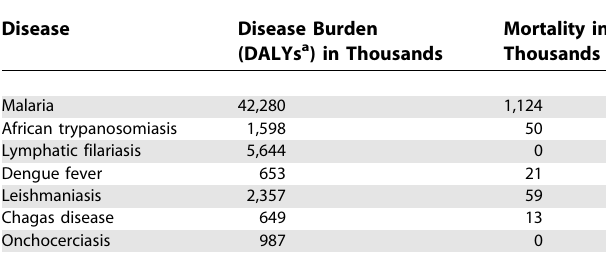
Table 2. Global Burden of Infectious Diseases Caused Due to Arthropod Vectors